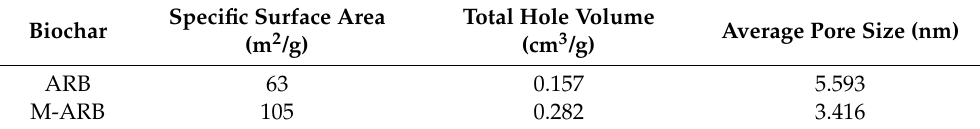
Table 1. Results of BET analysis of ARB and M-ARB.